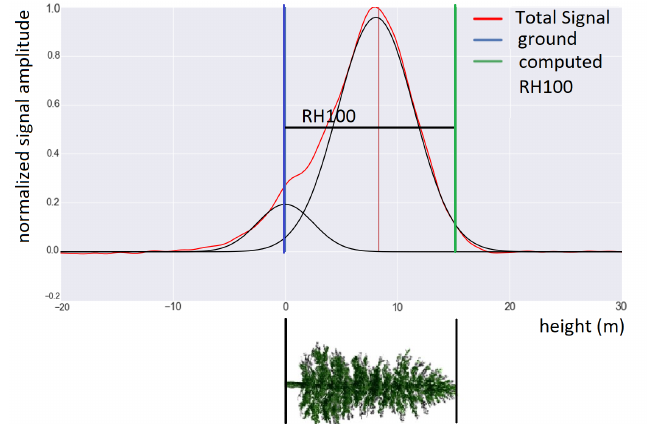
Figure 9. Case where the Gaussian decomposition helps the height retrieval.